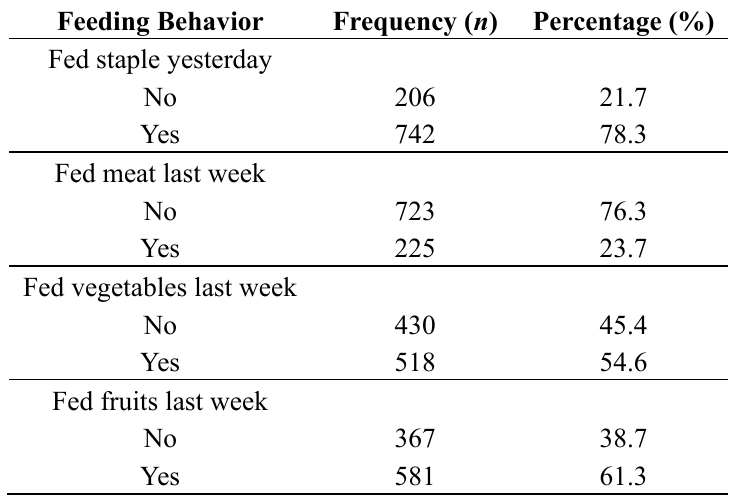
Table 5. Feeding practices of sample infants in rural Shaanxi Province ( N = 948).